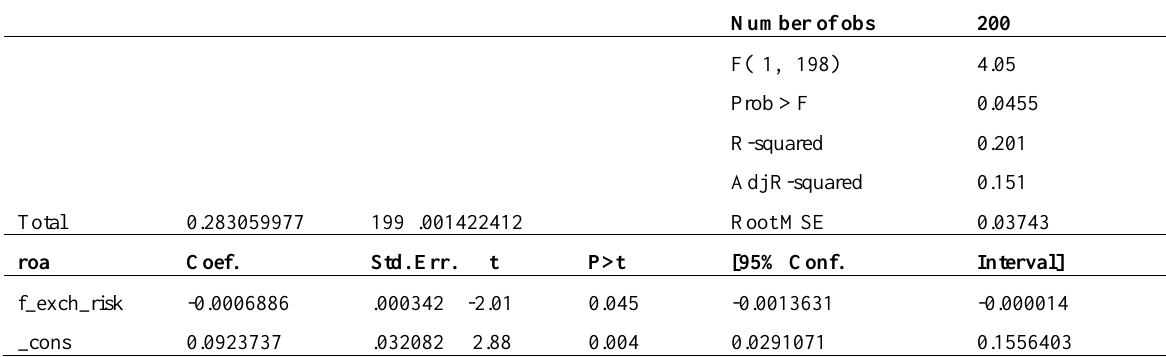
Table 4: Effect of the Foreign Rate Risk Exposure on Financial Performance